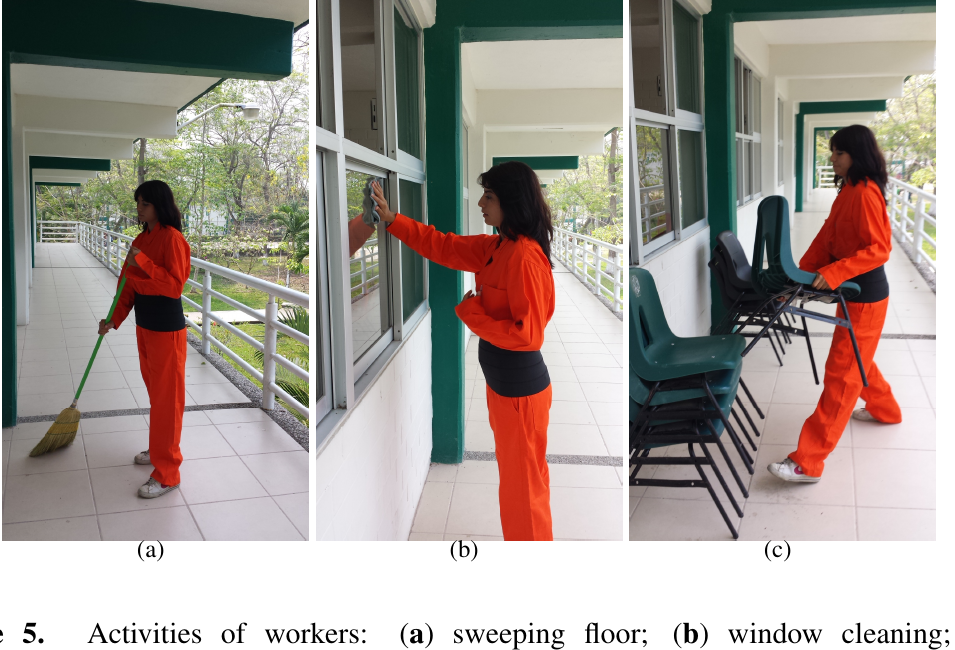
Figure 5. Activities of workers: ( a ) sweeping floor; ( b ) window cleaning; and ( c ) stacking